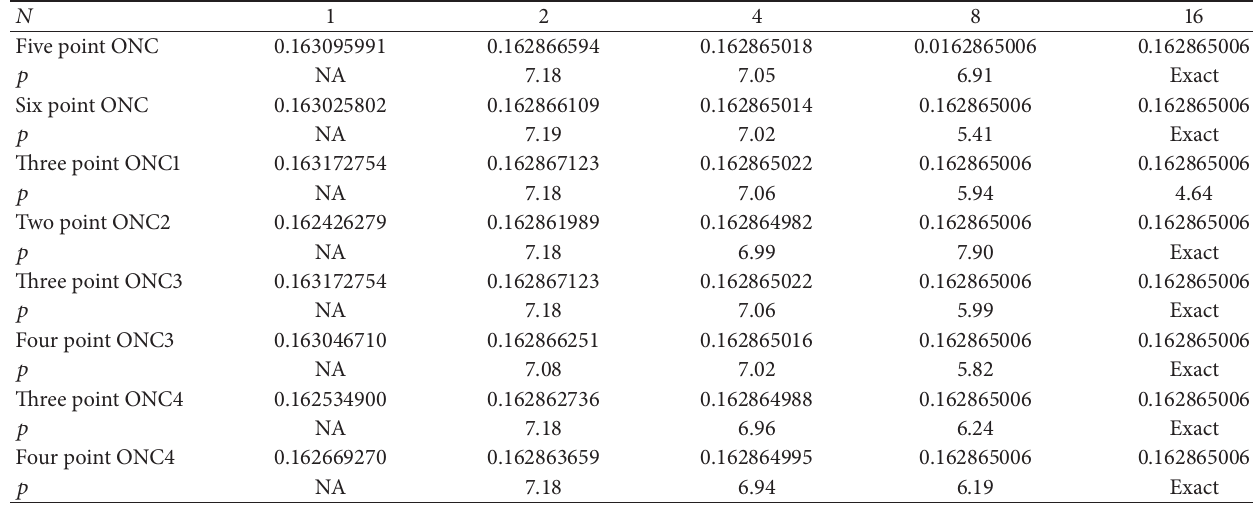
1 (𝑥 ln (1 + 𝑥)/(1 + 𝑥 2 ))𝑑𝑥 . 0